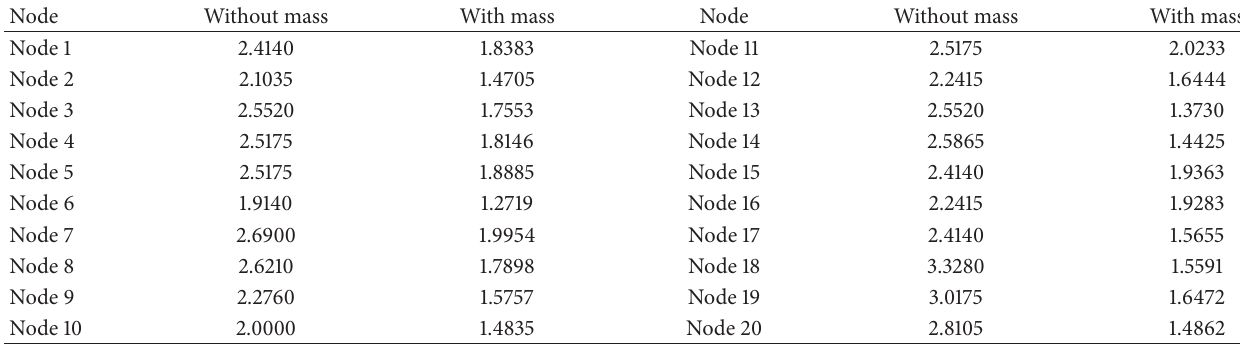
Table 2: The topology potential of artificial network nodes with two schemes.